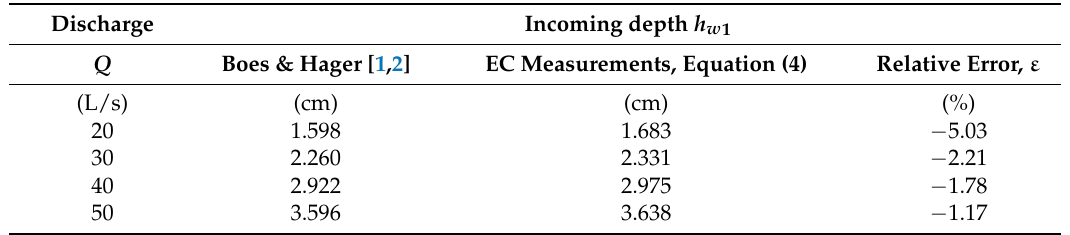
Table 3. Analysis of accuracy of method by [1,2] for estimating the incoming clear-water depth h w